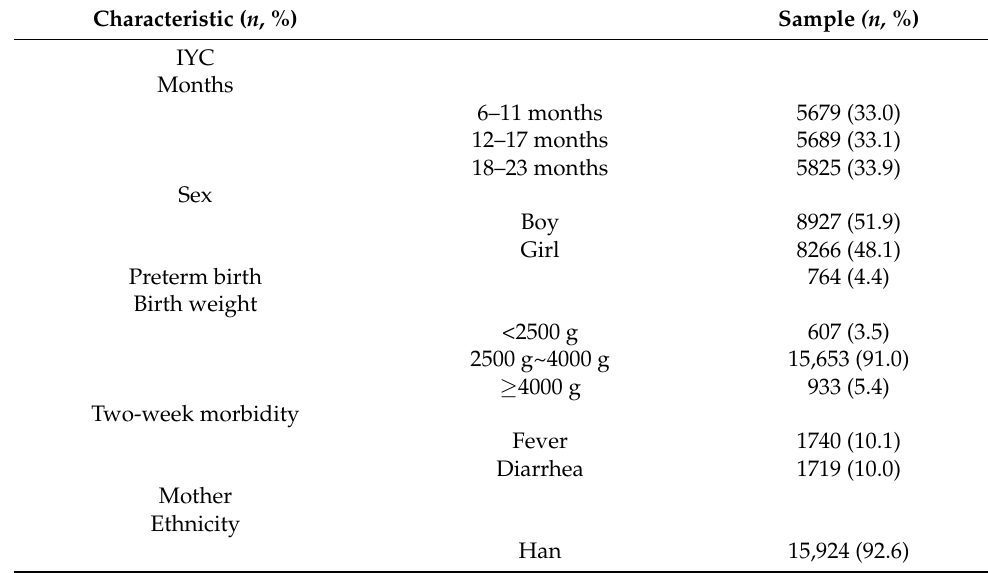
Table 1. Characteristics of surveyed children and their caregivers ( n =